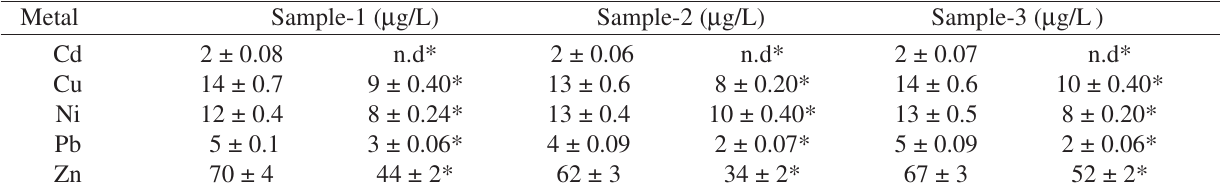
Table 3. Preconcentration by Cell-PAB flow procedure followed by FAAS in river water samples (with and without photocatalytic diges- tion, 100 mL sample, n = 3).